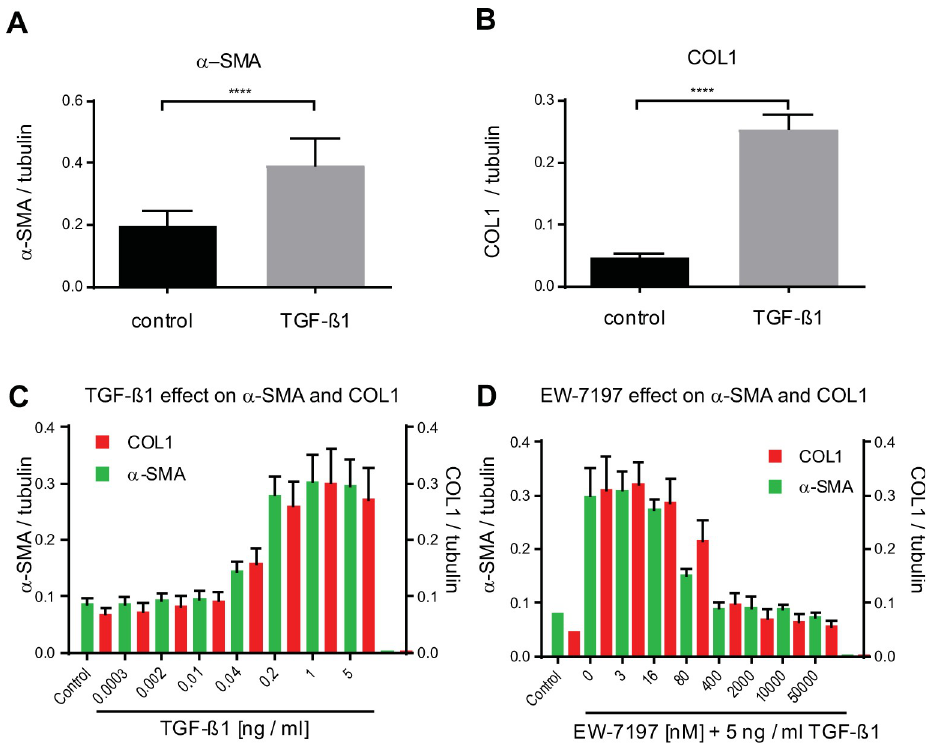
Fig 3. High–throughput–MS / MS quantification of α –SMA, COL1 and tubulin in lysate of NHLF cells. NHLF cells were stimulated with 5 ng / ml TGF– β 1 and lysed after 24 h. (A) α –SMA and (B) COL1 were quantified by MS / MS and normalized to tubulin. Data are means and bars show SD of control (black) and TGF– β 1–treated (grey) replicates (n = 16). A two–tailed unpaired t test comparing control to TGF– β 1–treated is given; ���� p < 0.0001. (C) NHLF cells stimulated with increasing concentrations of TGF– β 1 were lysed after 48 h and α –SMA, COL1, and tubulin (used for normalization), were quantified from single–wells by MS / MS. (D) NHLF cells were incubated at t = 0 h with dilution series of the ALK5–blocker EW–7197 (0–50,000 nM) and then stimulated with 5 ng / ml TGF– β 1 or not (control). Cells were lysed 48 h after TGF– β 1 addition and α –SMA and COL1 were quantified. 0.2% DMSO solvent was present in all wells. All analytes were normalized to tubulin. Bars show mean ± SD, n =